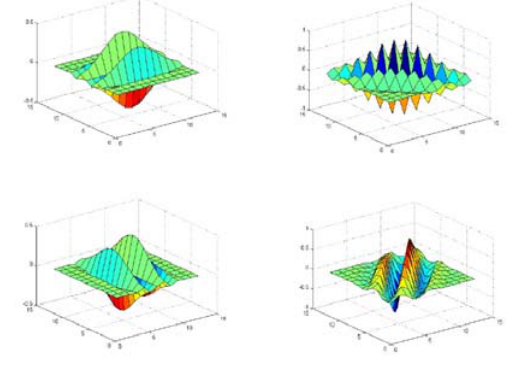
Fig. 3. Gabor filters visualization with different